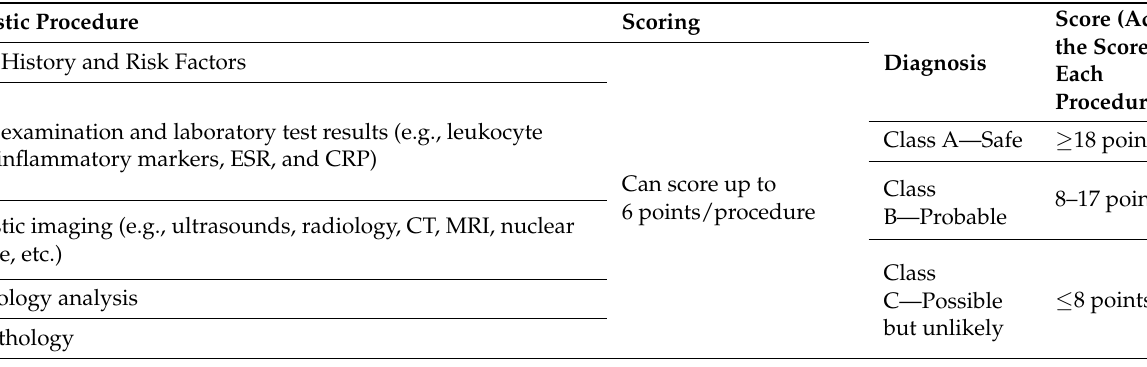
Table 1. Diagnostic criteria for osteomyelitis proposed by Schmidt et